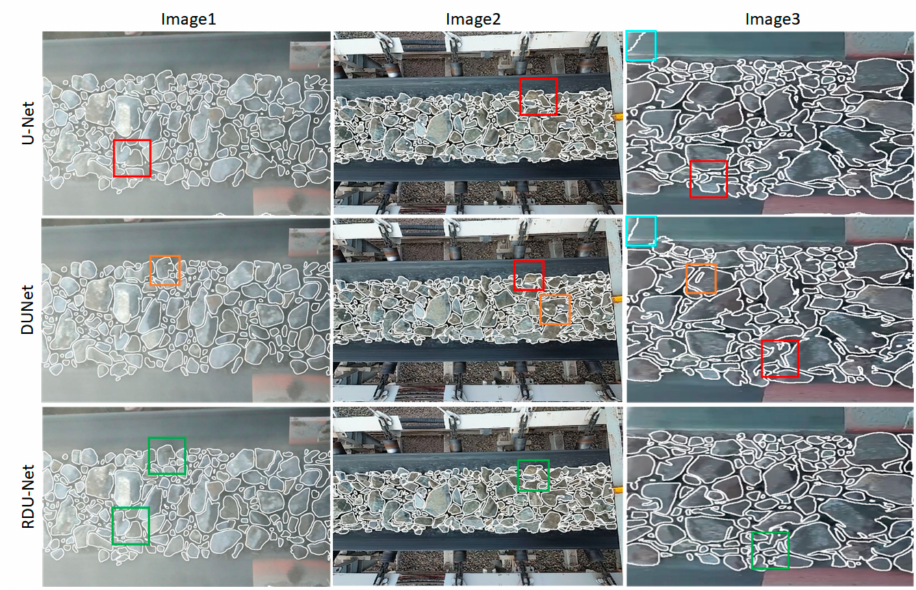
Figure 12. Comparison of contour maps divided by three models. Red box: under segmentation; Orange Box: over segmentation; Blue box: wrong identification of conveyor belt; Green box: good